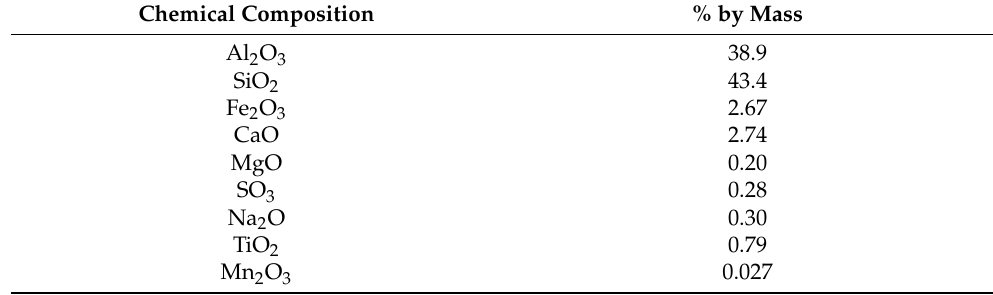
Figure 3. XRD pattern of MK sample.